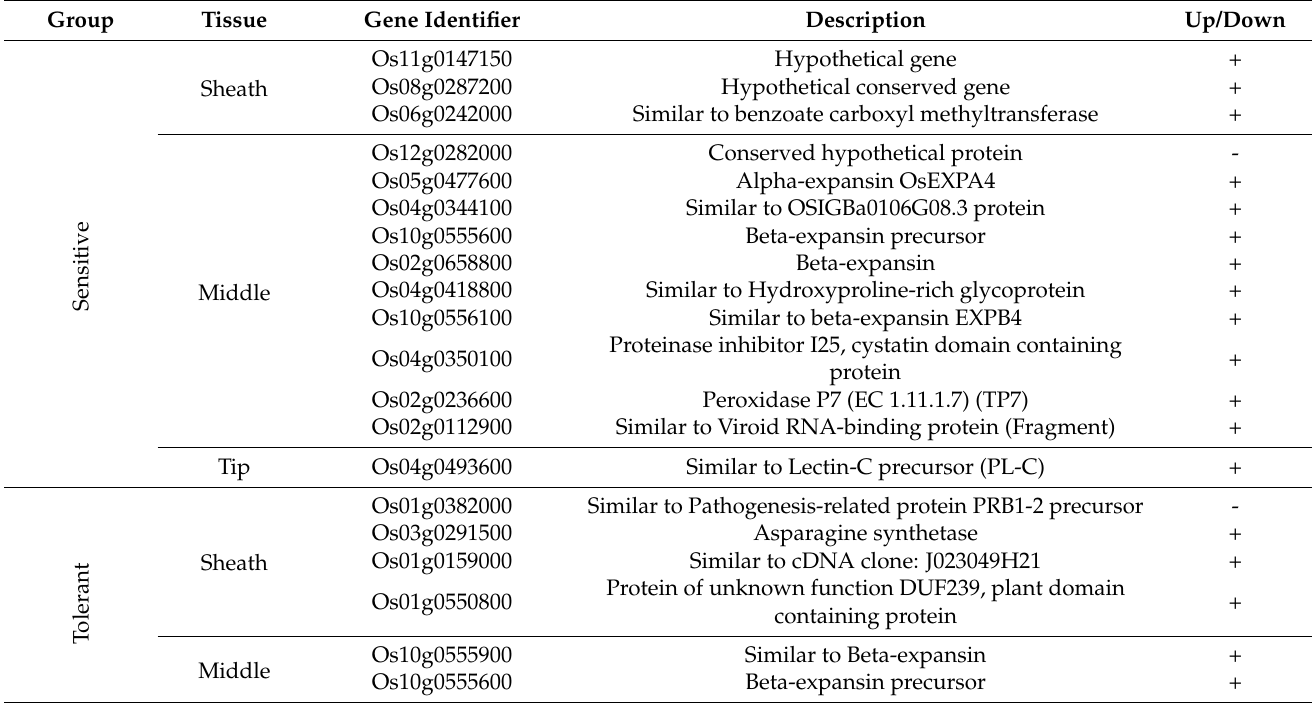
Table 3. Selected unique differentially expressed genes per segment with an absolute log 2 fold change larger than five for HNT-sensitive and HNT-tolerant rice cultivars. “+”, up-regulated; “-”, down-regulated. Group Tissue Gene Identifier Description Up/Down